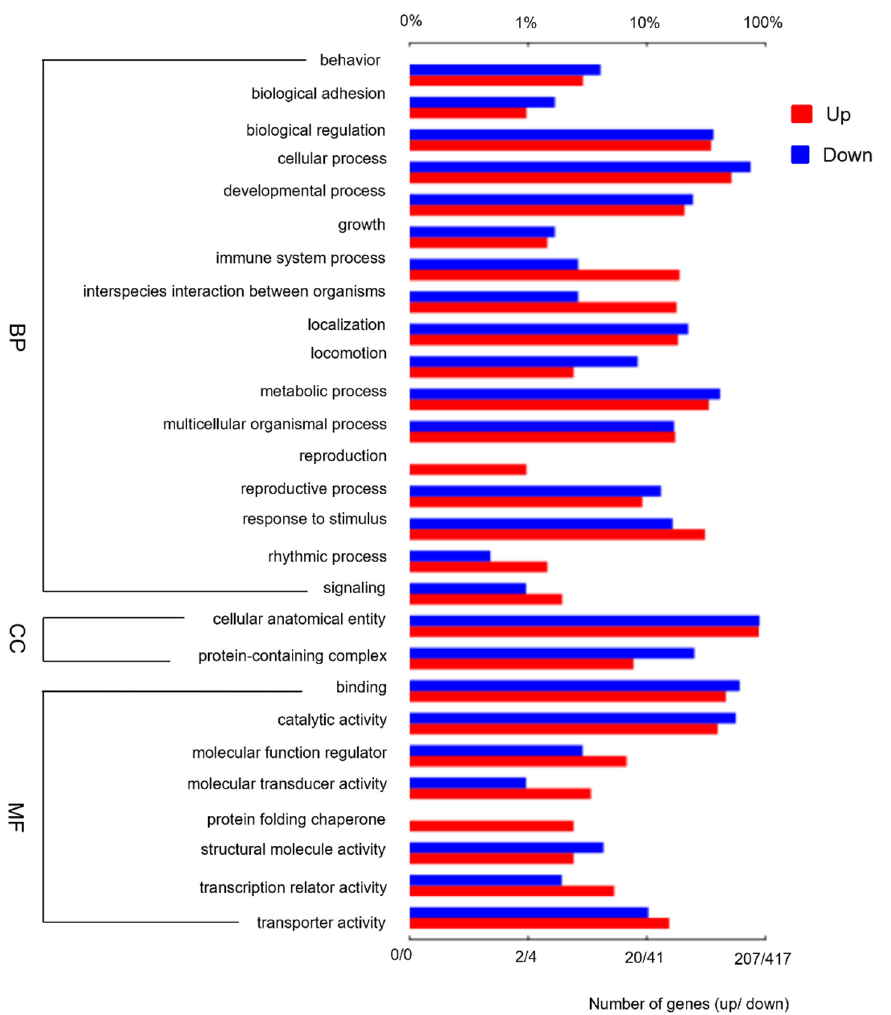
Figure 2. Summary of gene ontology (GO) classification of differentially expressed genes in B. mori . The upper top x -axis represents the proportion of the percentage of the number of genes corresponding to the function, and the lower x -axis represents the number of genes corresponding to the function. Up, up-regulated genes; Down, down-regulated genes. BP, biological process; CC, cellular component; MF, molecular function.